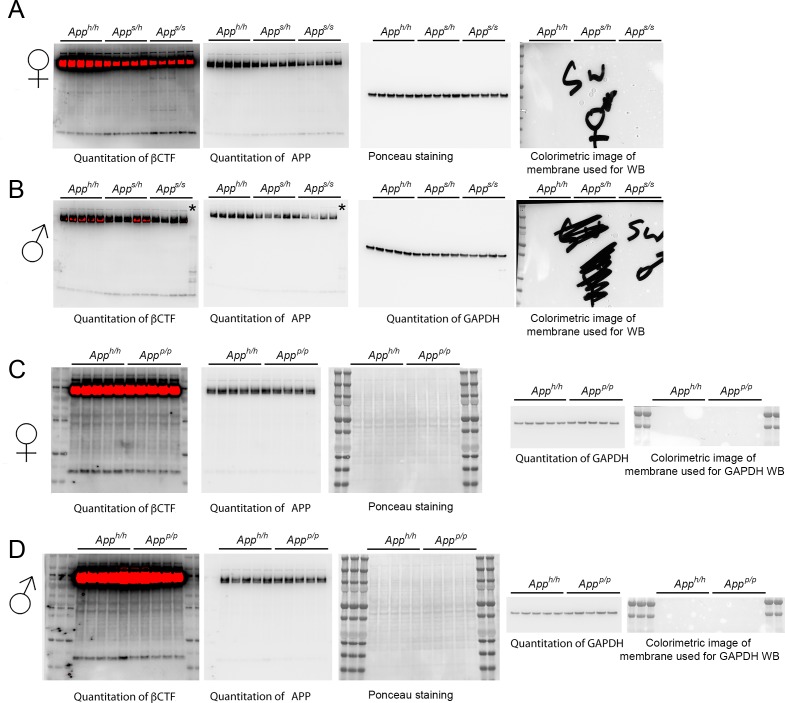
Western blots, ponceau stain and colorimetric images used for quantitation shown in Figure 7 for: (A) βCTF, APP and GAPDH in Apph/h, Apps/h and Apps/s females; (B) βCTF, APP and GAPDH in Apph/h, Apps/h and Apps/s males (as it is evident from the blots, one Apps/s sample was degraded and indicated with * and therefore that animal was excluded from any analysis); (C) βCTF, APP and GAPDH in Apph/h and Appp/p females; (B) βCTF, APP and GAPDH in Apph/h and Appp/p males.